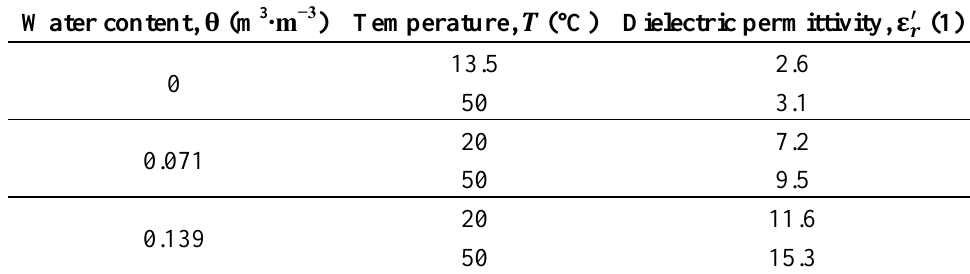
Table 2. Variation of with temperature at three volumetric water contents with the CS650.